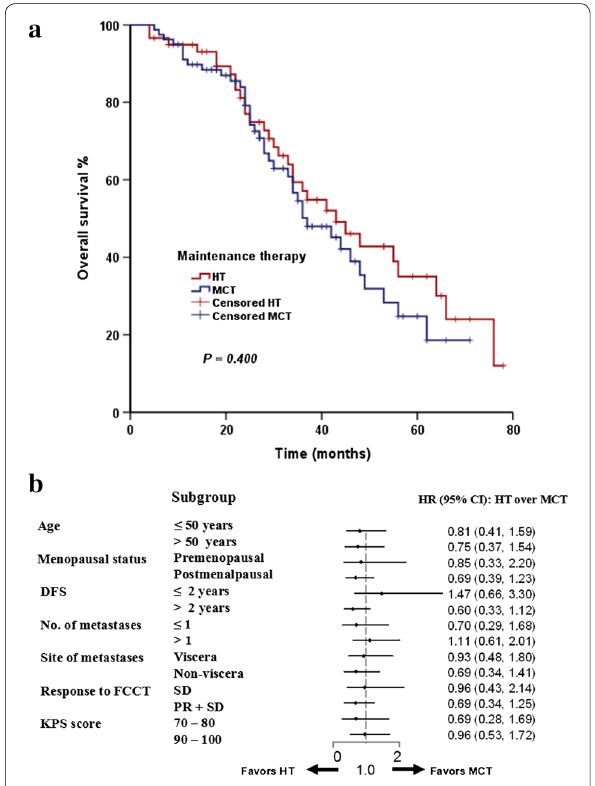
Fig. 2 Comparison of overall survival between the HT group and the MCT group. a Estimation of overall survival, censored on the date of last assessment. b Forest plot (OS analysis); HR < 1 favors HT. DFS disease‑free survival, FCCT first‑line capecitabine‑based combina‑ tion chemotherapy, KPS Karnofsky performance status, CR complete response, PR partial response, SD stable disease, HT hormonal